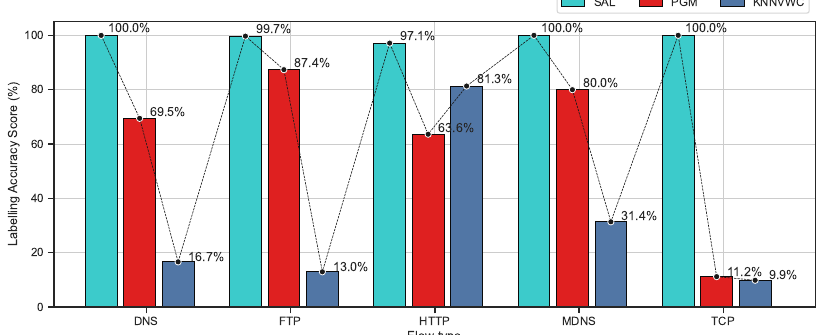
Figure 11. Comparison of labeling processes based on F-measure metrics on the ISCX dataset.